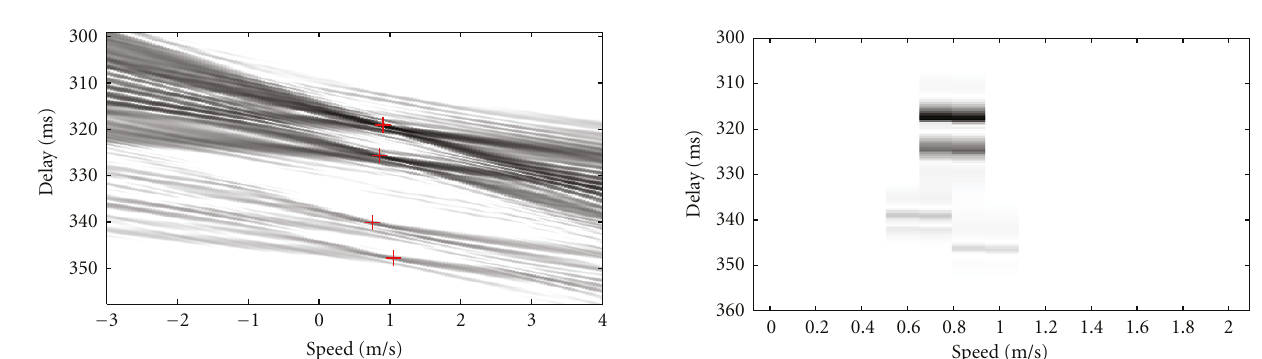
Figure 16: WSF estimated coe ffi cients of the four detected path groups using the WALF method and the received LFM signal in the BASE07 experimental